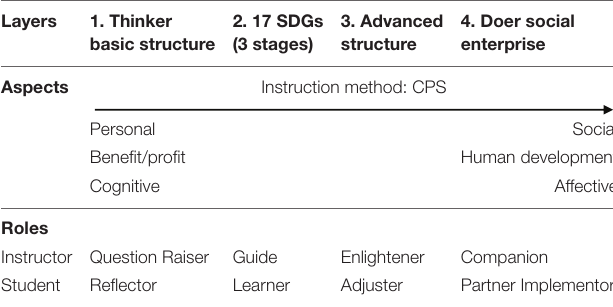
TABLE 1 | The roles and concepts of the CIE education